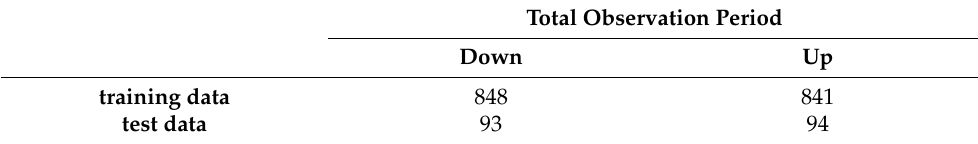
Table 2. Sample size.